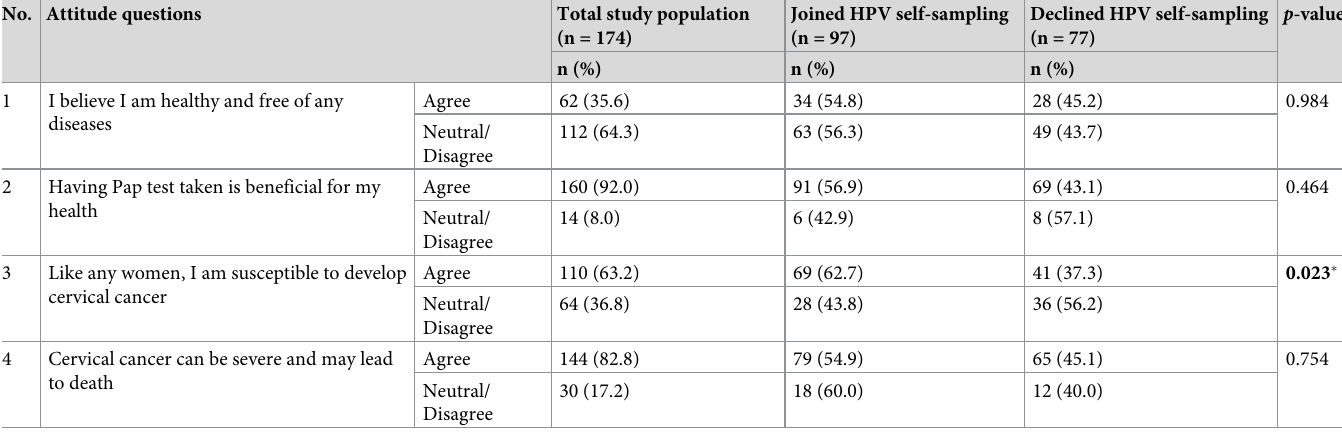
Table 3. Attitudes towards cervical cancer screening among non-attendees at JPSHC, Brunei (Jan–Dec 2019), between those who agreed and declined HPV self-